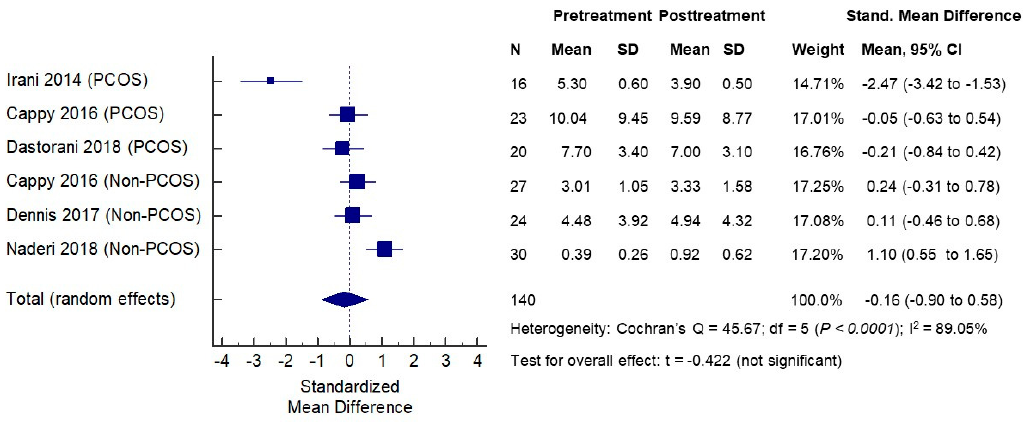
Figure 3. E ff ects of vitamin D supplementation on serum AMH levels—all Figure 3. Effects of vitamin D supplementation on serum AMH levels—all women. Figure 3. Effects of vitamin D supplementation on serum AMH levels—all women.